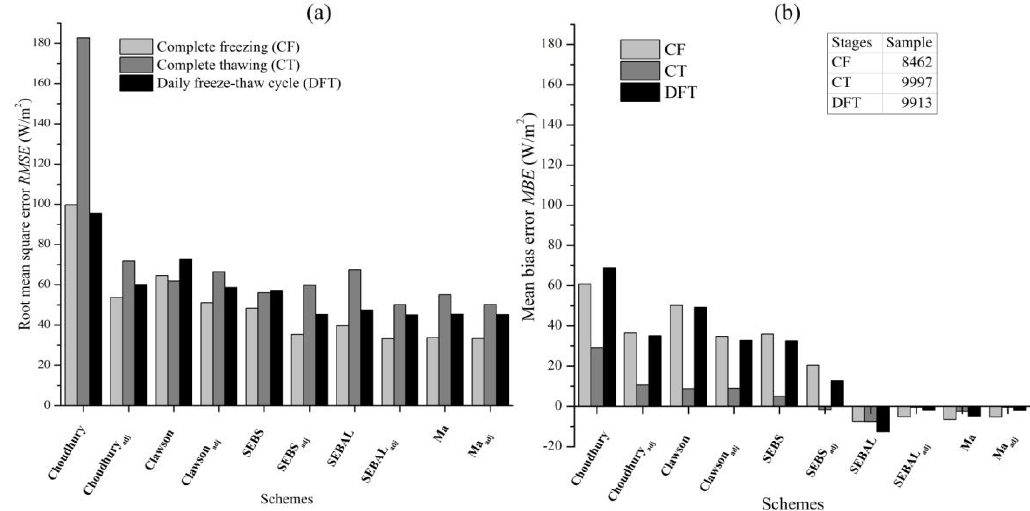
Figure 3. Root mean square error ( RMSE ) ( a ) and mean bias error ( MBE ) ( b ) of each scheme at different stages (CF, complete freezing; DFT, daily freeze-thaw cycle; CT, complete thawing) of the freeze-thaw cycle. The table in the upper right corner in Figure 3b corresponds to the number of samples in the three stages.